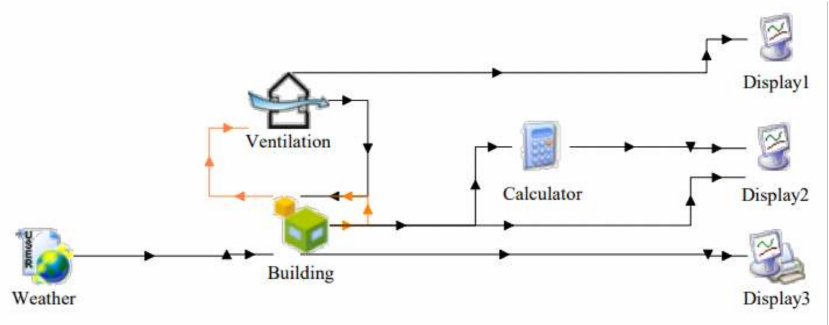
Figure 5. System model diagram of TRNSYS.